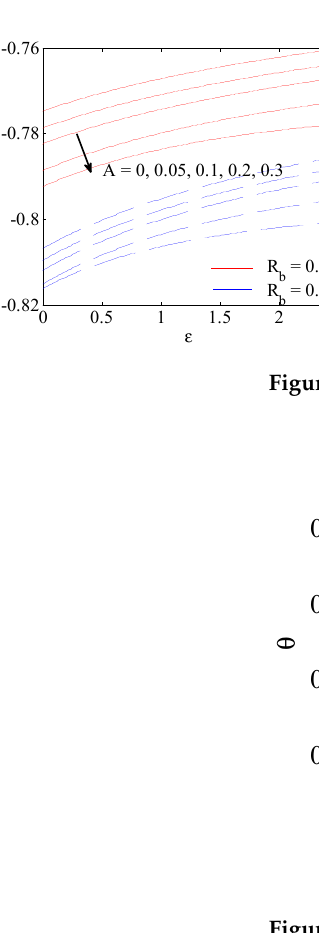
Figure 6. Fluctuations of C f , Nu and Nn due to the factor M .